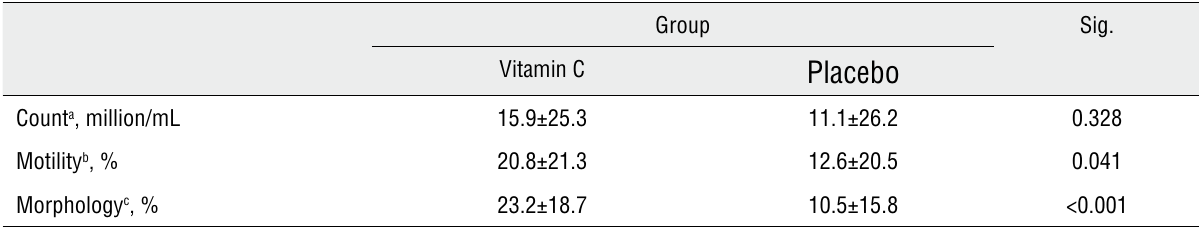
Table 3 - Comparing the mean differences of indices before and after surgery status between the intervention and placebo